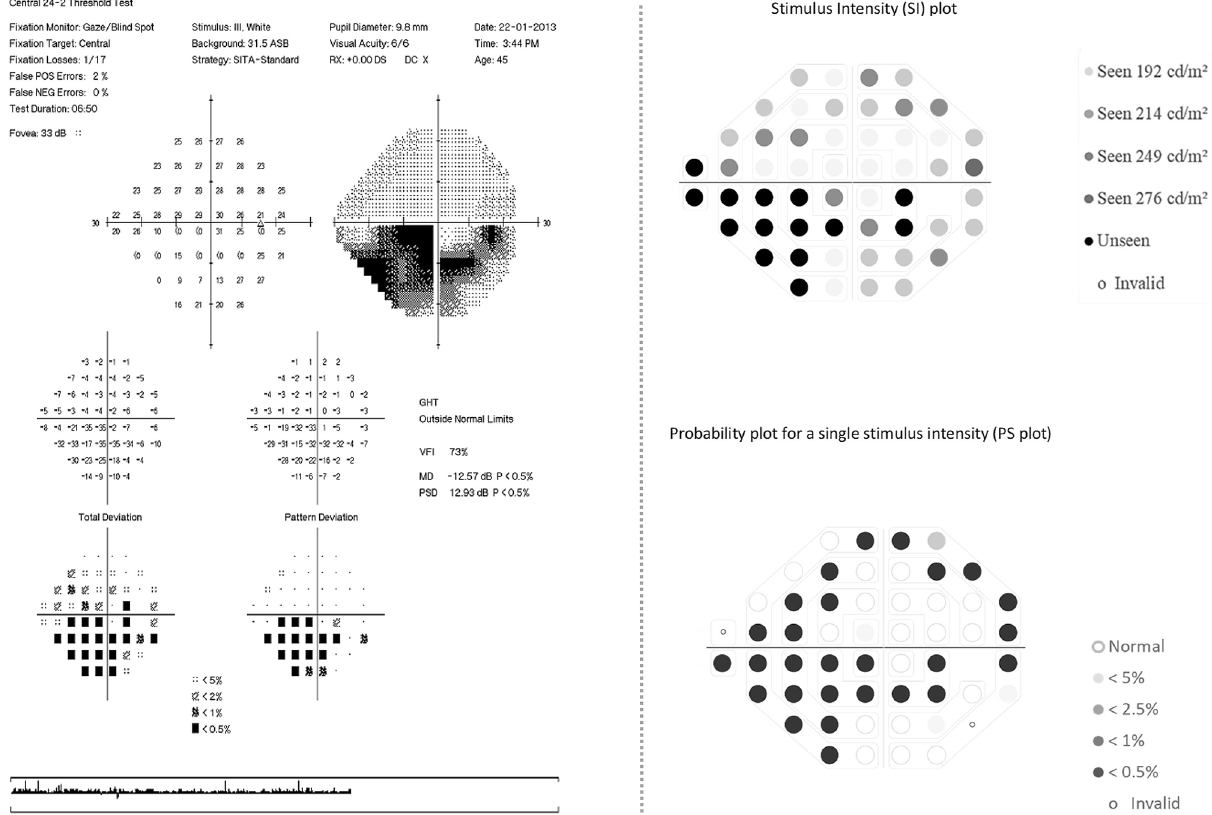
Figure 4. Illustration of HFA and EMP visual field report of a patient with mild glaucomatous visual field defect; Left panel: presentation of HFA 24-2 SITA-standard visual field report identified with mild glaucoma showing shallow nasal defect. HFA indicates Humphrey visual field analyser; SITA, Swedish Interactive Threshold Algorithm. Right panel: the EMP plots for the same patient in 4, left panel, Right top panel presenting saccadic reaction time (SRT) plot at 54 points with corresponding numerical grey scale; Right bottom panel presenting probability plot corresponding to the SRT responses at the stimulus intensity 214 cd/m 2 presents visual field defect nasally with additional scattered areas of delayed SRT. EMP indicates eye movement perimetry; HFA, Humphrey field analyzer; SITA, Swedish interactive threshold